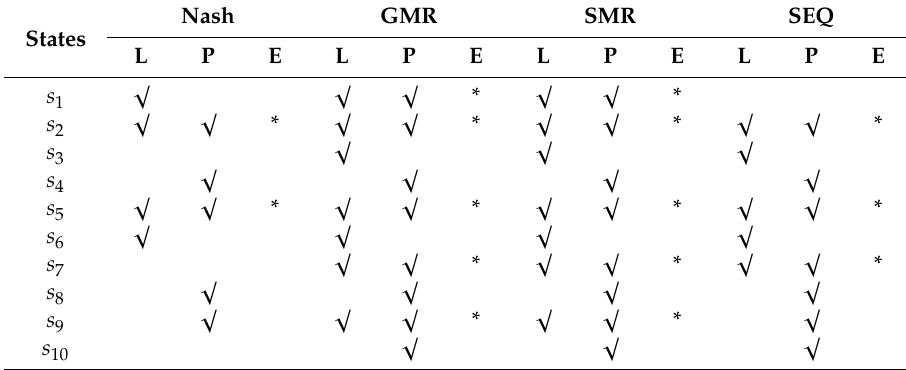
Table 8. The outcomes of stability analyses for the brownfield conflict. L—local government; P—public;